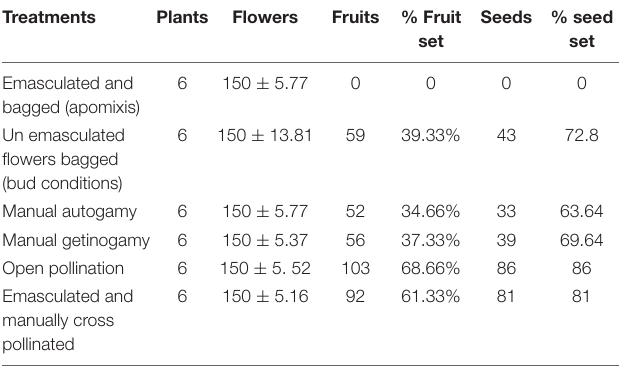
TABLE 6 | Seed set in Rheum webbianum following different treatments. Treatments